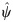
A spike-based grid score.a) Illustration of the ψ measure for 6-fold symmetry. Left: A reference ‘atom’ (black disc) with four neighbors (colored discs). Arcs show the angles, ϕl, to a reference axis (dashed black line) for all neighbors l ∈ {1, 2, 3, 4}. The blueish neighbors lie on the corners of a hexagon. The red neighbor is a defect to this hexagonal structure. Right: Sum of four unit vectors with directions given by 6ϕl (colored arcs). Vectors associated with neighbors that lie on the corners of the same hexagon (blueish colors) point in the same direction. The vector associated with the defect (red) points in a different direction. The length |ψ| of the resulting vector, normalized by the number of neighbors (black arrow), quantifies how much the reference atom is embedded in a hexagonal structure. The direction arg(ψ) of the vector—divided by 6 to reverse the previous rotation—indicates the orientation of the hexagon. b) Detection of the neighborhood shell. Locations of spikes of a grid cell and smoothed histogram of the pairwise distances between all spikes. Dashed lines indicate the automatically detected neighborhood shell. Top: Generated data. Bottom: Experimental recording kindly provided by [10]. c) Preventing false positives by discarding other symmetries. Example |ψ(M)| and ψ^ values for a spike (black) with few neighbors (blue) in six different configurations. d) Same spike maps as in b, color-coded with the spike-based grid score ψ^k (left) and the spike-based orientation θk=16arg(ψk) (right).